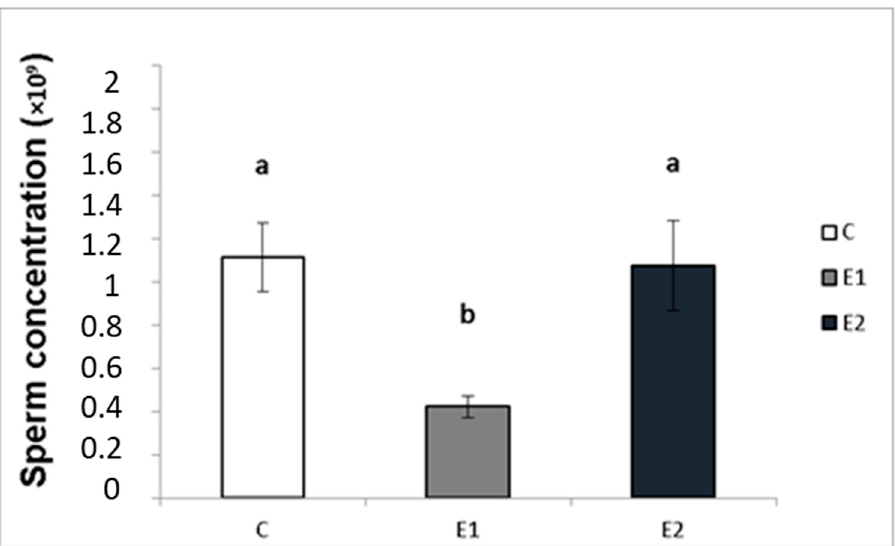
Figure 4. Sperm concentration in rabbits fed with green tea. C (without dietary green tea). E1–5 g green tea/100 kg normal food. E2–20 g green tea/100 kg normal food. Values and error bars express means ± SEM. a vs. b—difference is significant at p < 0.05.